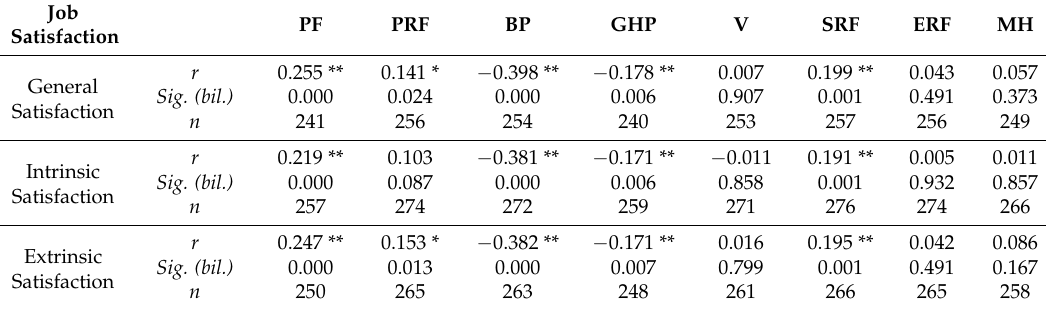
Table 6. Correlation between job satisfaction and occupational health